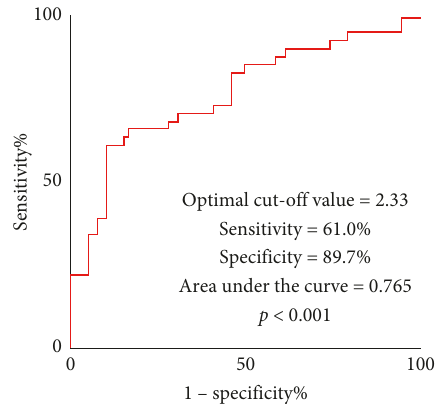
Figure 3: Receiver operating characteristic curves of the novel proposed predictive model. The optimal threshold of the model for predicting left ventricular recovery at 3-month follow-up was 2.33 with sensitivity 0.610, specificity 0.897, and area under the curve 0.765 ( p < 0 . 001 )